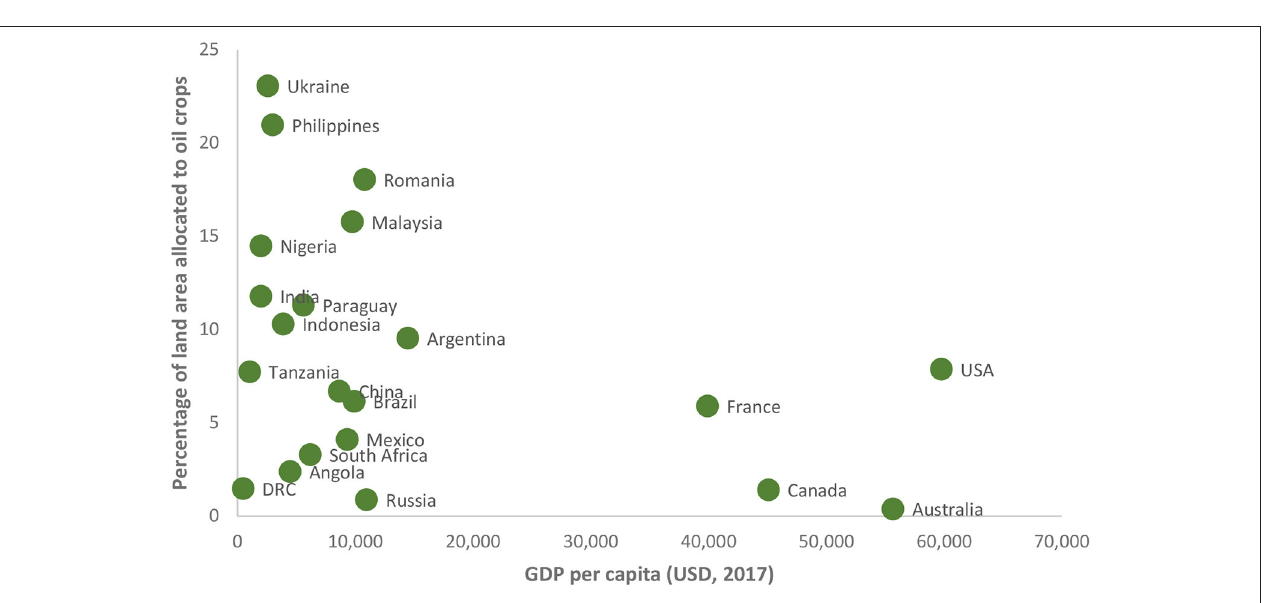
FIGURE 3 | Gross Domestic Product (GDP) per capita vs. percentage of each country’s land allocated to oil crops. Green dots represent the 20 largest vegetable oil producers (FAOSTAT,